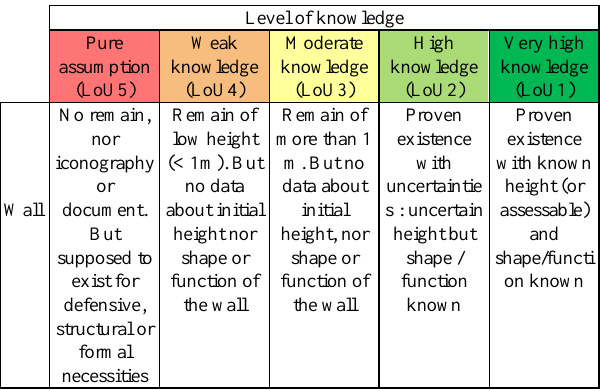
Table 1: Description of the level of knowledge (and level of